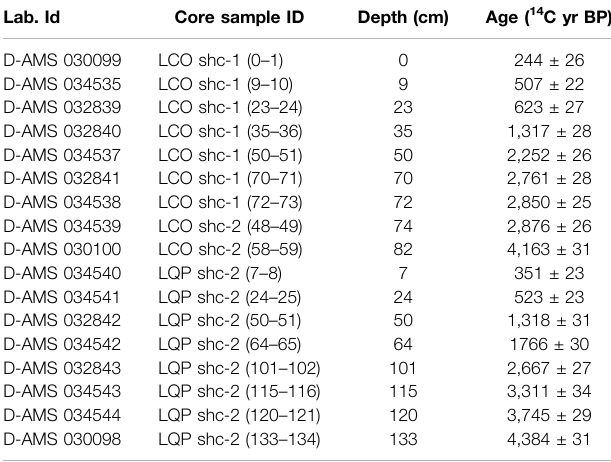
TABLE 1 | Radiocarbon-dated from cores of Laguna Corralito (LCO) and Laguna Quebrada Parada (LQP). All dates were obtained from bulk sediments, and all dates were adjusted by 244 ± 26 14 C